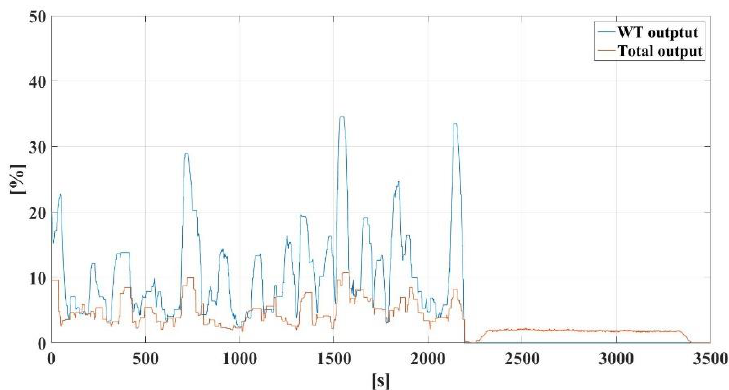
Figure 13. Field test result 2: fluctuation rate per minute.